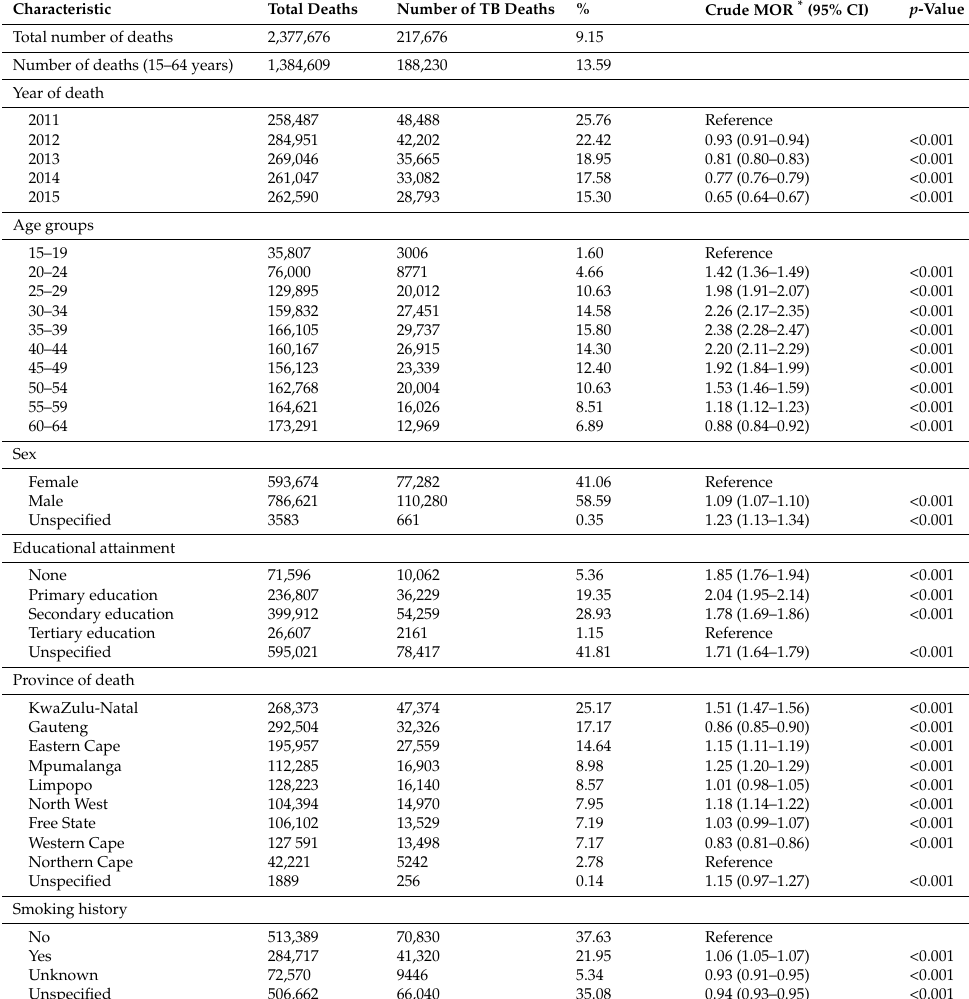
Table 1. Summary of tuberculosis (TB) deaths among persons aged 15 to 64 years and selected characteristics—South Africa, 2012–2016 ( n =